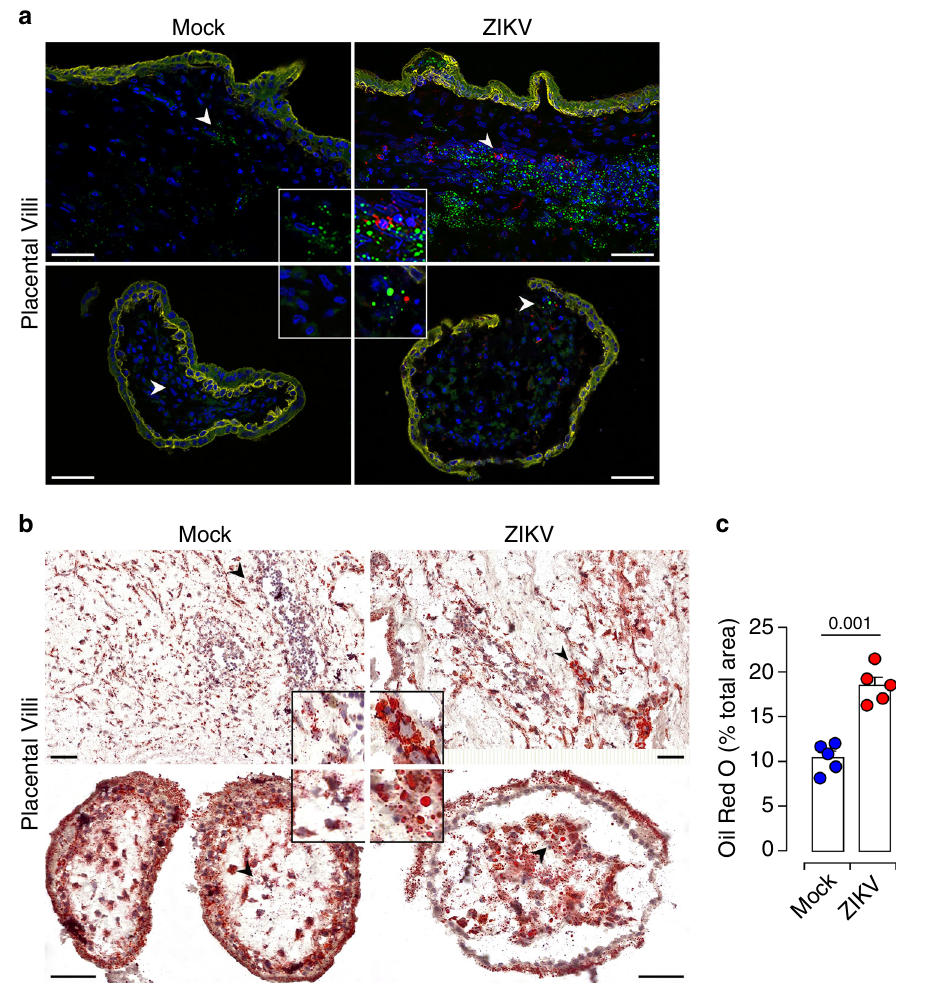
Fig. 3 Accumulation of LDs in ZIKV-infected placenta. a Representative thin sections of matched mock and ZIKV-infected placentas 5 dpi. Immunostaining is performed with anti-NS3 (red) and anti-CK7 (yellow) antibodies. LDs are stained with the BODIPY 493/503 dye (green) and nuclei with DAPI (blue). High magni fi cation of the indicated area (arrowhead) is shown in insets. Scale bar, 50 μ m. Data are representative of at least three independent experiments. b Oil Red O staining of neutral lipid in tissue sections from matched mock- and ZIKV-infected placenta (red). Nuclei are counterstained with hematoxylin. High-magni fi cation images of the indicated area (arrowhead) are shown in insets. Scale bar, 50 μ m. c Quanti fi cation of Oil Red O staining by Image J showing increased staining area in the infected placental sections. All data are presented as mean ± SEM of fi rst trimester placentas from fi ve independent donors. P values are computed using paired two-tailed Student ’ s t test. Source data are provided as a Source Data fi